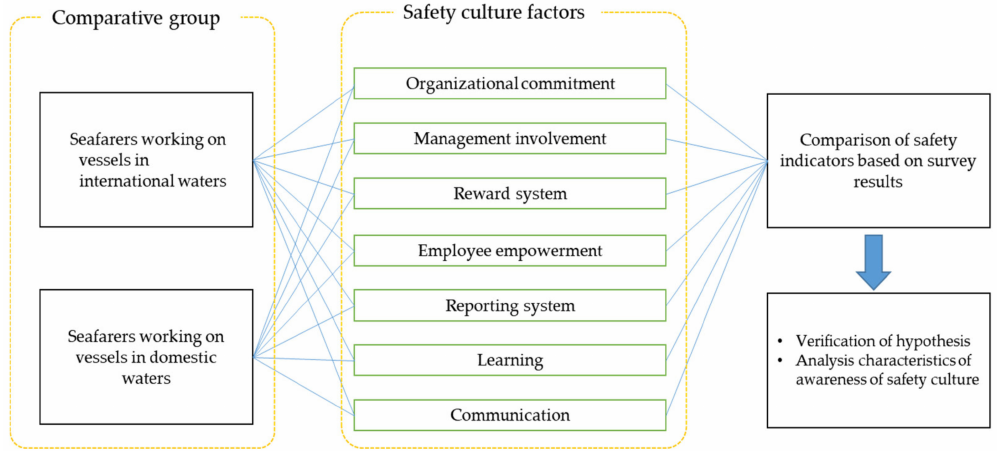
Figure 2. Research model (Source: adapted from